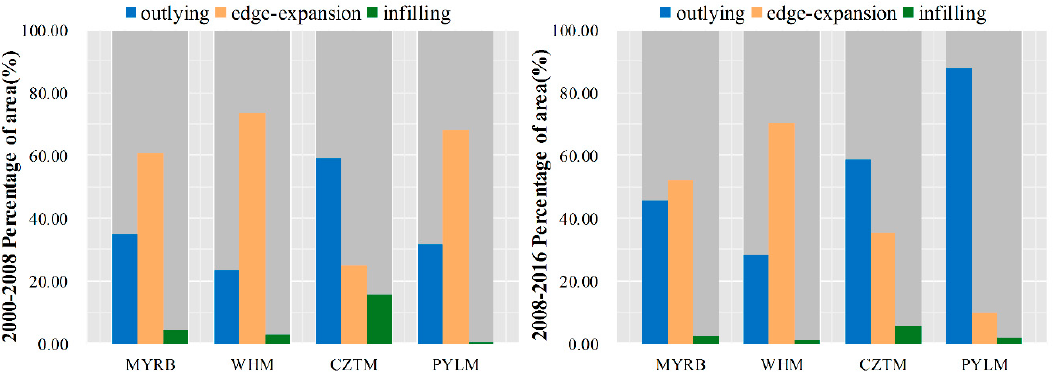
Figure 5. Urban growth types in the MYRB urban agglomeration from 2000 to 2016.